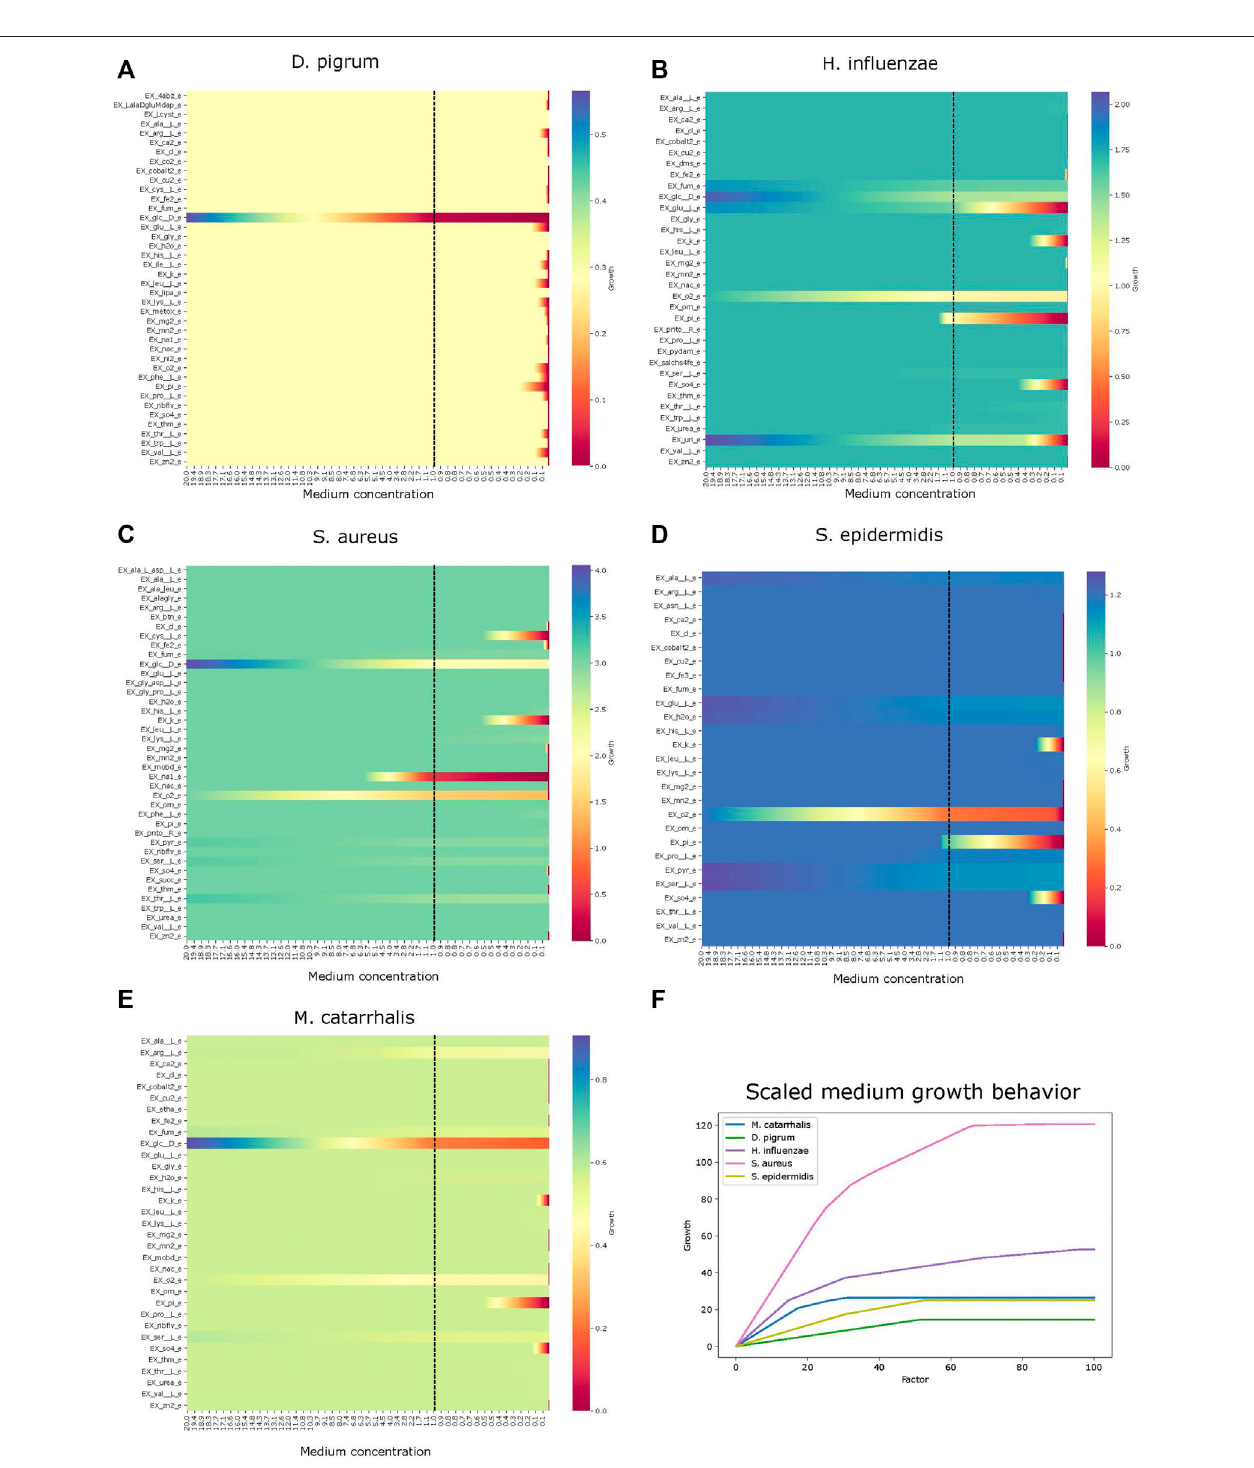
FIGURE 3 | Effect of growth behavior on an increase of metabolites. Different models show how the growth scales are affected with abundance of metabolites. Panel (A) is species Dolosigranulum pigrum . Panel (B) , Haemophilus in fl uenzae . Panel (C) , Staphylococcus aureus . Panel (D) , Staphylococcus epidermidis . Panel (E) , Moraxella catarrhalis . Panel (F) , growth comparison.